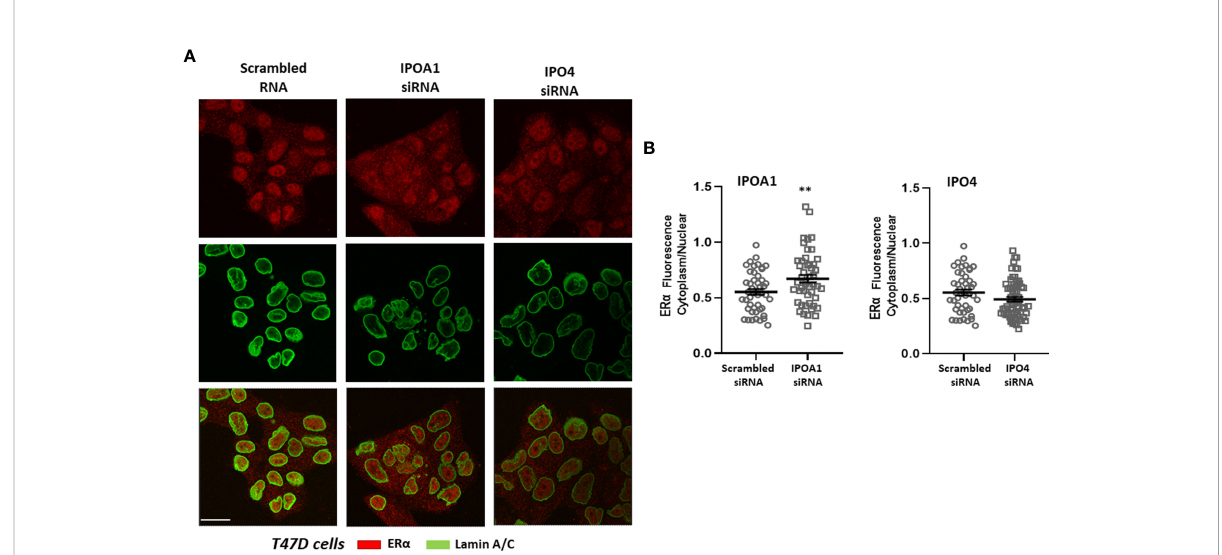
FIGURE 2 (A) Representative confocal pictures of T47D cells stained for estrogen receptor alpha (ER a ) (red) and lamin A/C (green) (3 rd raw is their overlay). T47D cells were either transfected with a scrambled siRNA or a speci fi c siRNA for importin a (IPOA1) or importin 4 (IPO4), used as a negative control, as our bioinformatics approach did not identify any importin 4 NLS. Magni fi cation x1260 (scale bar, 40 m m). (B) Intensity of fl uorescence in the cytoplasm and nucleus was quanti fi ed (see Material and Methods for details) in at least 50 cells per condition from 4